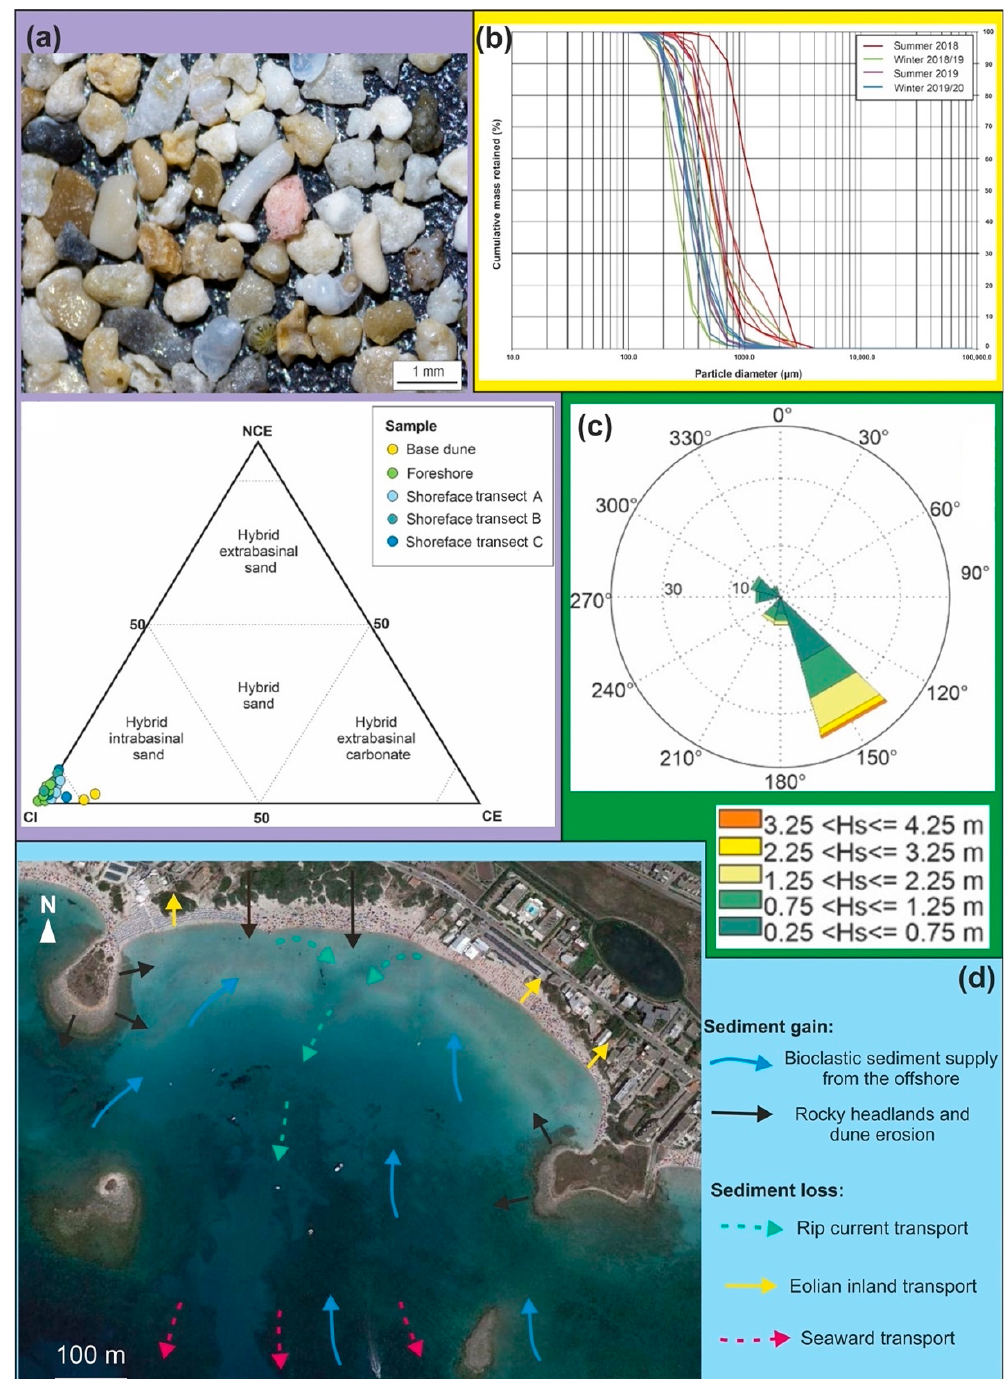
Figure 14. Gathering the main results for beach dynamics investigation. ( a ) Petrographical features; ( b ) sand texture of the bioclastic beach sand; ( c ) wave height distribution; ( d ) beach dynamics sketch scheme (modified from [102]).